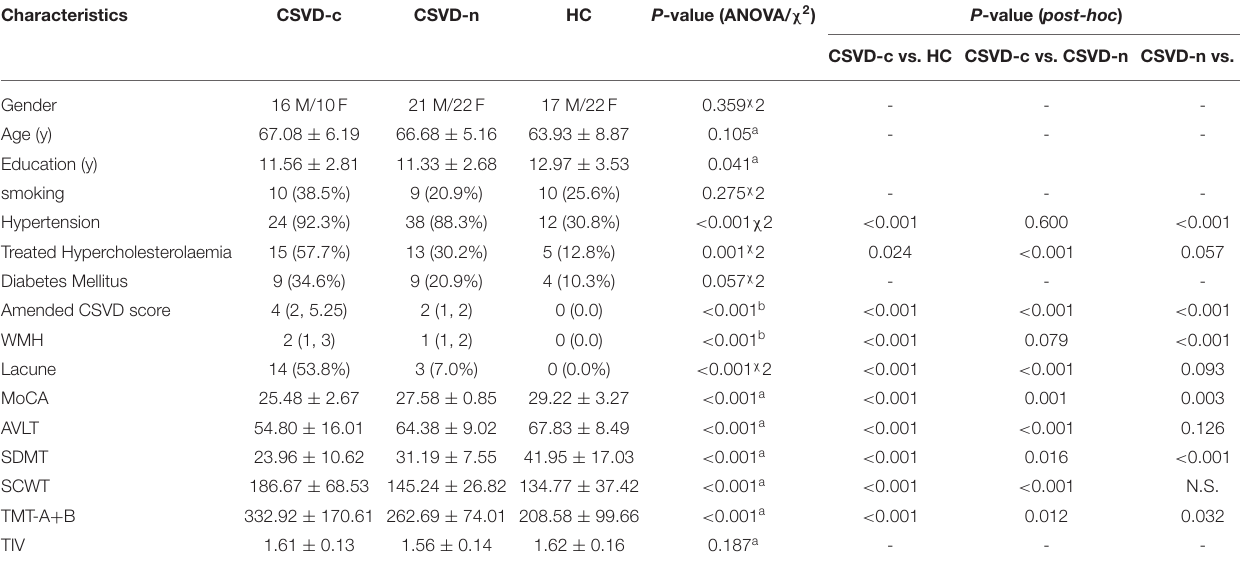
TABLE 1 | Demographic and clinical characteristics of CSVD patients and controls. Characteristics